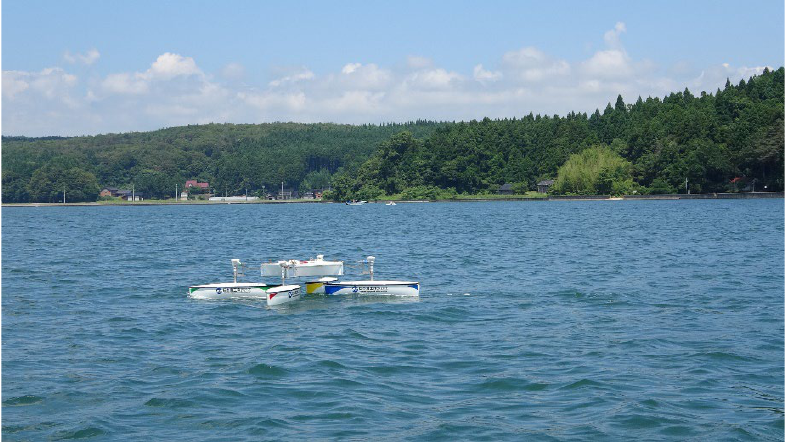
Figure 1. The Quadmaran vessel sailing on the sea.